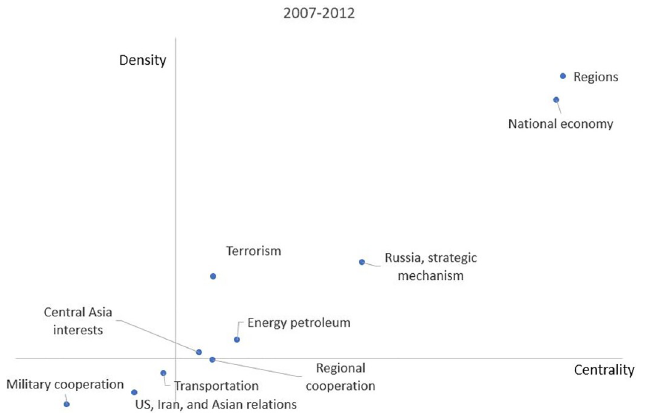
Fig 7. Strategic diagram between 2007 and